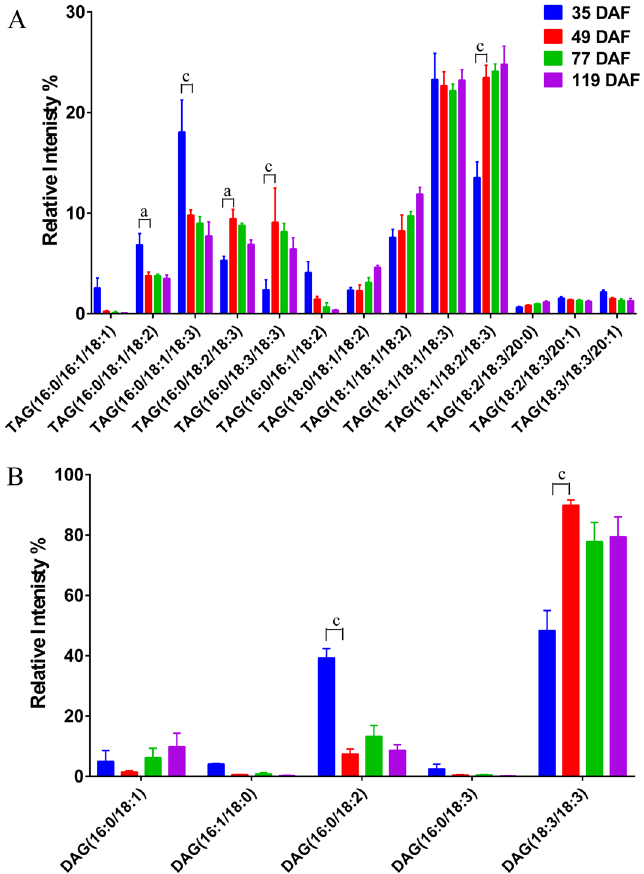
Figure 3. Changes in the relative abundances of the major molecular species comprising ( A ) triacylglycerol (TAG) and ( B ) diacylglycerol (DAG) during the development of the Paeonia ostii kernel. DAF, days after fertilization. Means ± SD (n = 8) are shown. Lowercase letters correspond to significant differences between adjacent developmental stages: a, p < 0.05; b, p < 0.01; c, p < 0.001. Only molecular species representing > 0.5% of total abundance are